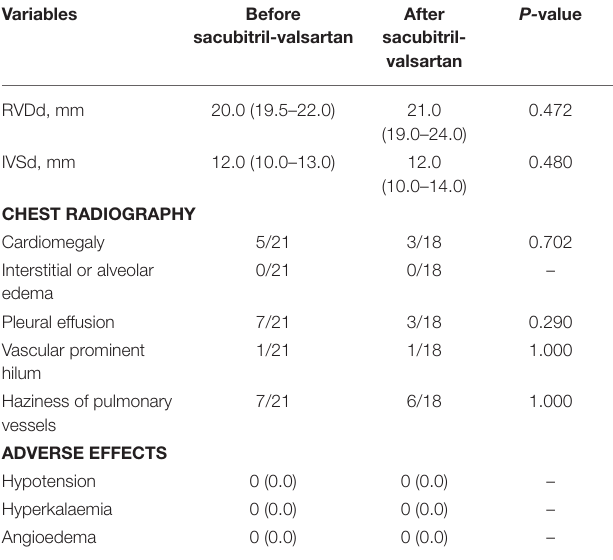
TABLE 2 | Comparisons of the characteristics of PD patients before and after initiating sacubitril-valsartan with observation period of 3–12 months.